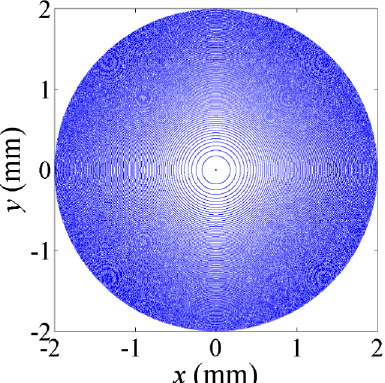
FIG. 7. Transverse distribution of the input electron beam at the cathode. In this design, the number of electron rings is 131 and the linewidth of each electron ring is set to 30 nm. The chosen dimensions are within the reach of today ’ s nanofabrication techniques.